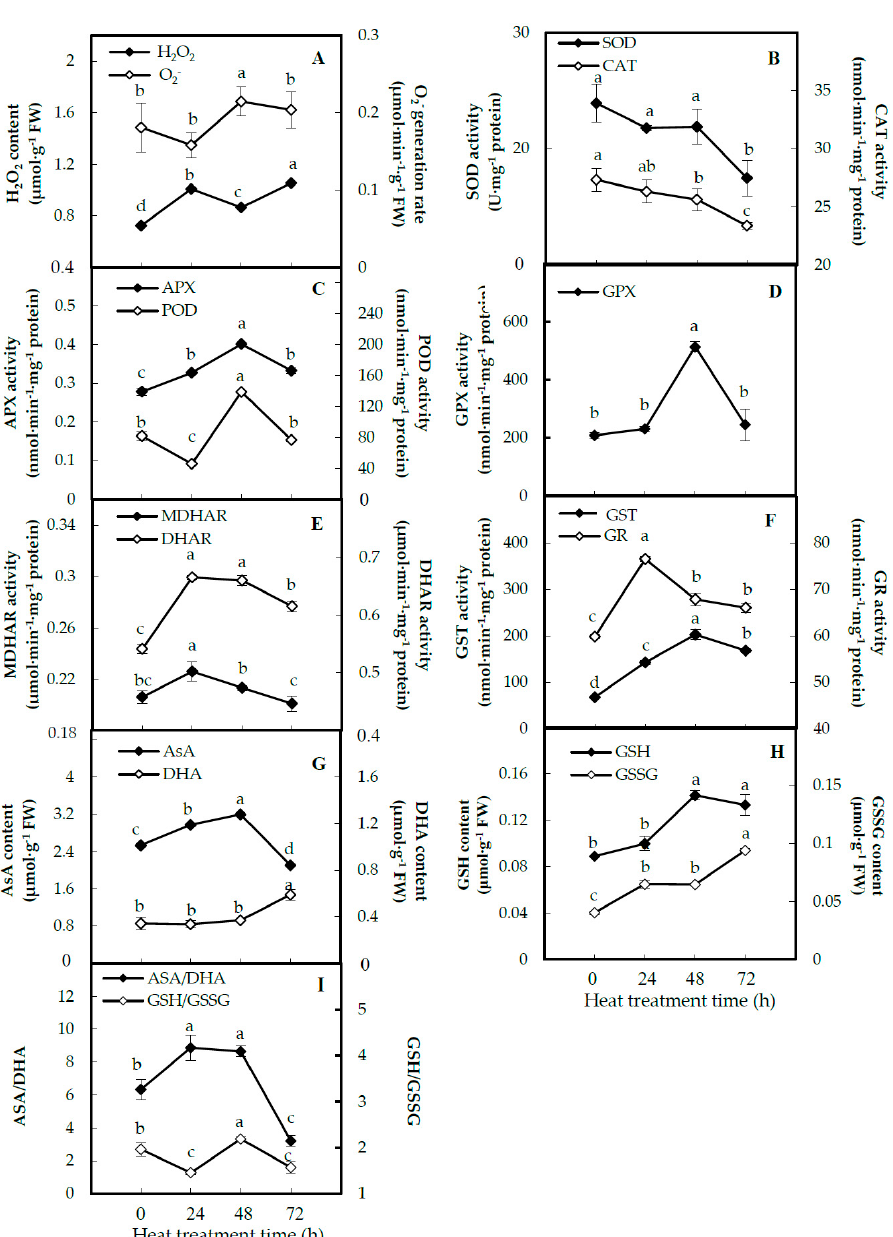
Figure 4. Activities of antioxidant enzymes and antioxidant contents in leaves of spinach Sp73 under heat-stress treatment. ( A ) Hydrogen peroxide (H 2 O 2 ) content and superoxide anion radical (O 2 •− ) generation rate; ( B ) activities of superoxide dismutase (SOD) and catalase (CAT); ( C ) activities of ascorbate peroxidase (APX) and peroxidase (POD); ( D ) glutathione peroxidase (GPX) activity; ( E ) activities of monodehydroascorbate reductase (MDHAR) and dehydroascorbate reductase (DHAR); ( F ) activities of glutathione reductase (GR) and glutathione S-transferase (GST); ( G ) contents of ascorbate (AsA) and dehydroascorbate (DHA); ( H ) contents of reduced glutathione (GSH) and oxidized glutathione (GSSG); ( I ) ratios of AsA/DHA and GSH/GSSG. The values were determined after plants were treated with heat stress at 37 °C/32 °C (day/night) for 0 h, 24 h, 48 h and 72 h and are presented as means ± SD ( n =3). The different small letters (a–d) indicate significant difference ( p < 0.05) among different treatments.